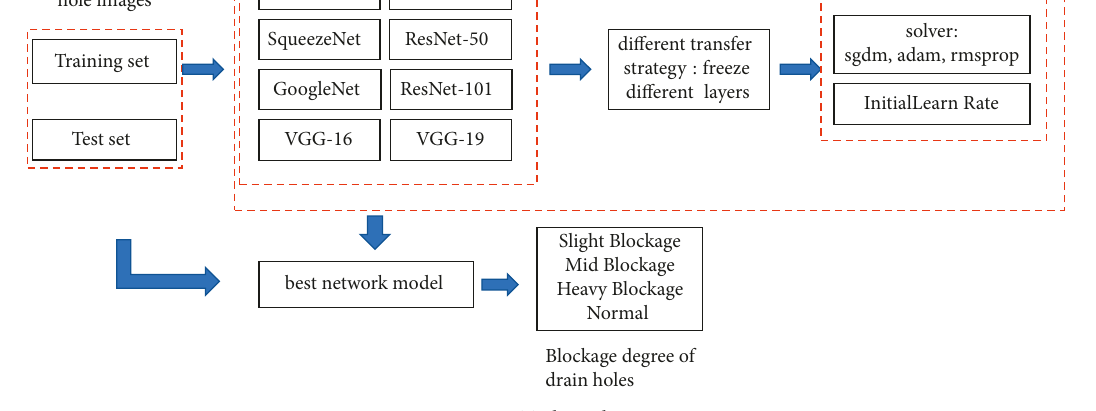
Figure 1: Technical route.